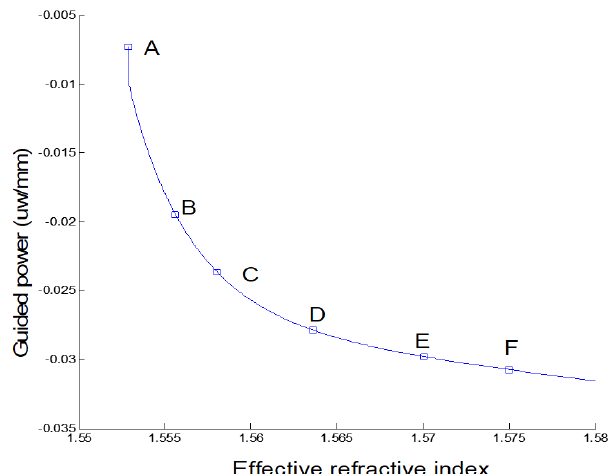
Figure 2. Dispersion curve of three-layer optical metamaterial waveguide with nonlinear cladding and substrate at d f = 2 μ m.